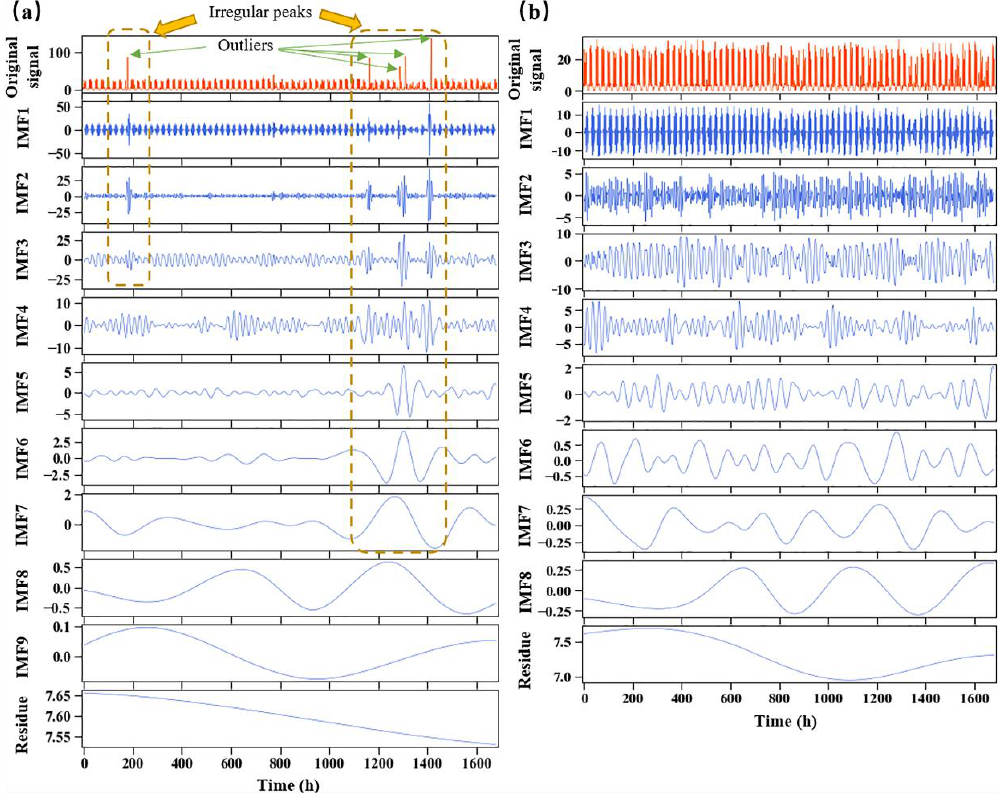
Figure 4. Original signals, their corresponding Intrinsic Mode Functions (IMFs), and residue results of Complete Ensemble Empirical Mode Decomposition with Adaptive Noise (CEEMDAN) for ( a ) initial time series, and ( b ) time series processed by Isolation Forest.